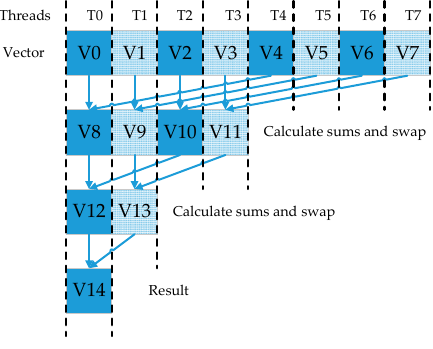
Figure 7. Reduction process in CUDA.